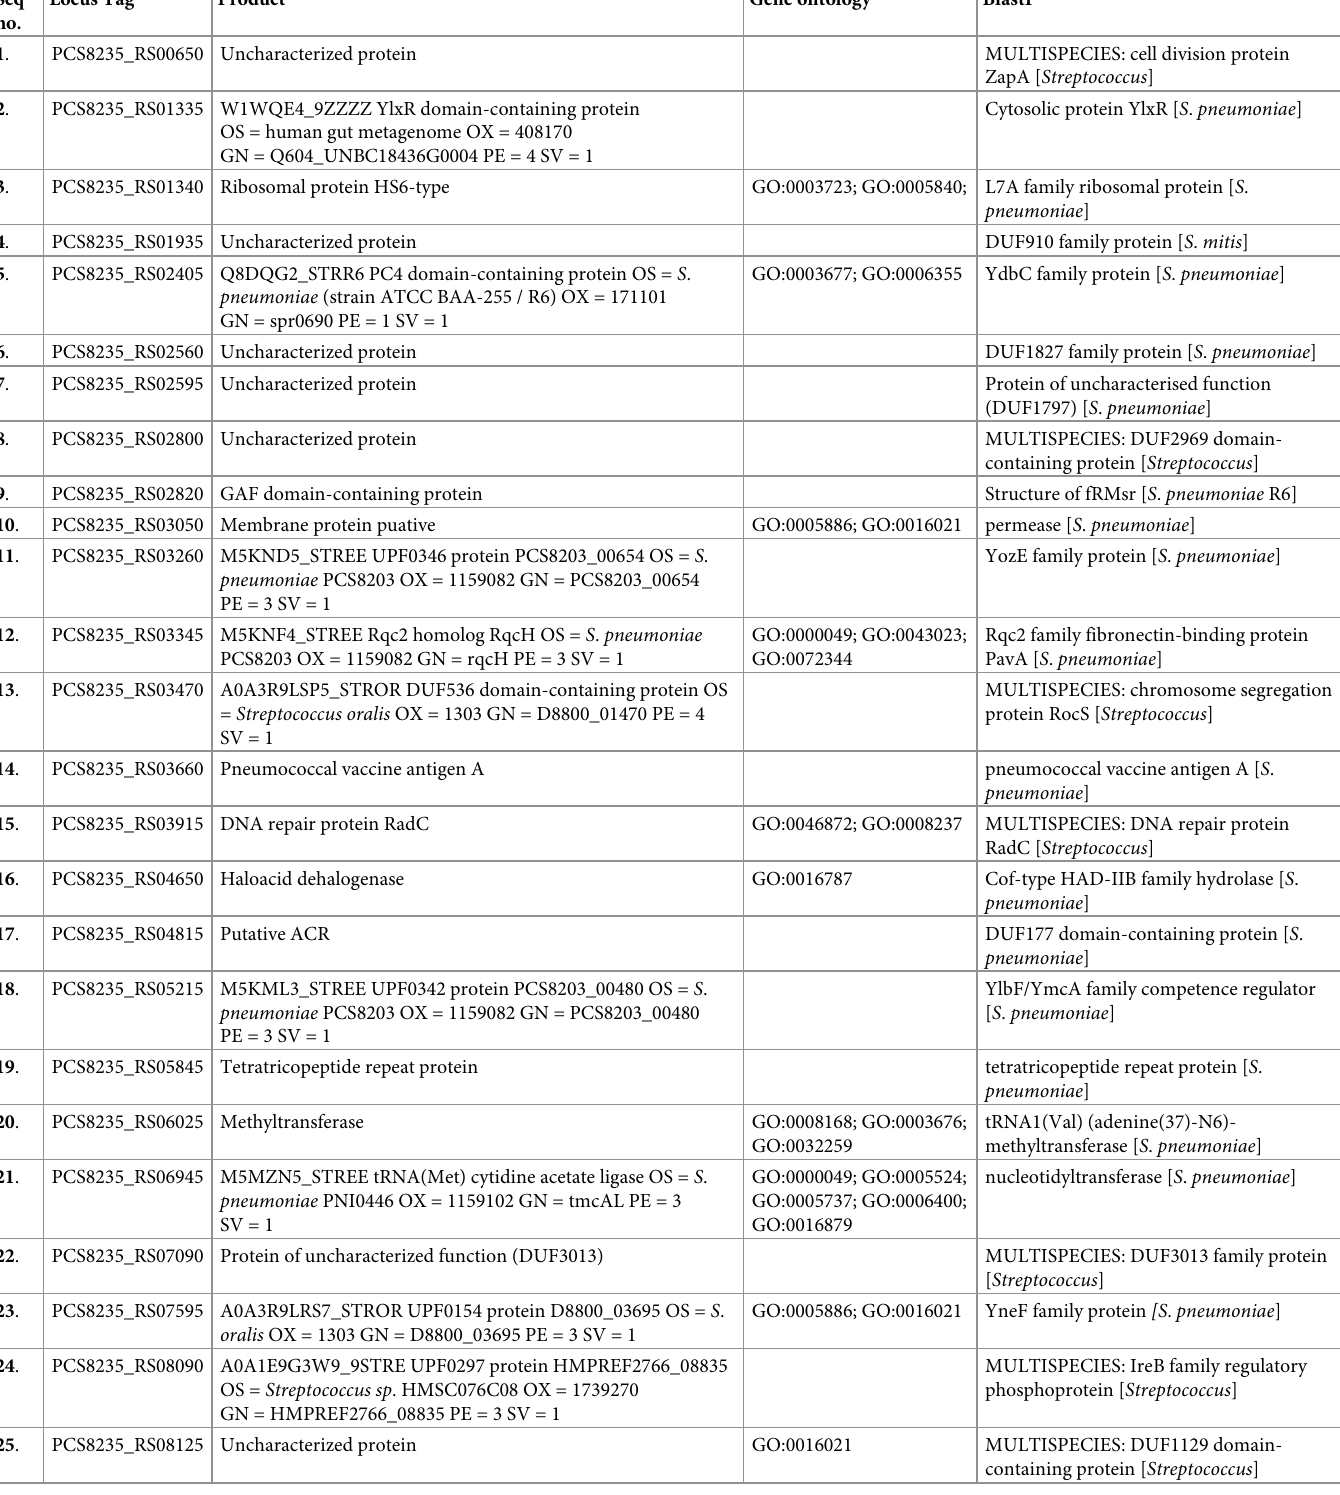
Table 1. Annotated products for HPs in S . Pneumoniae as determined by GO FEAT platform. Seq